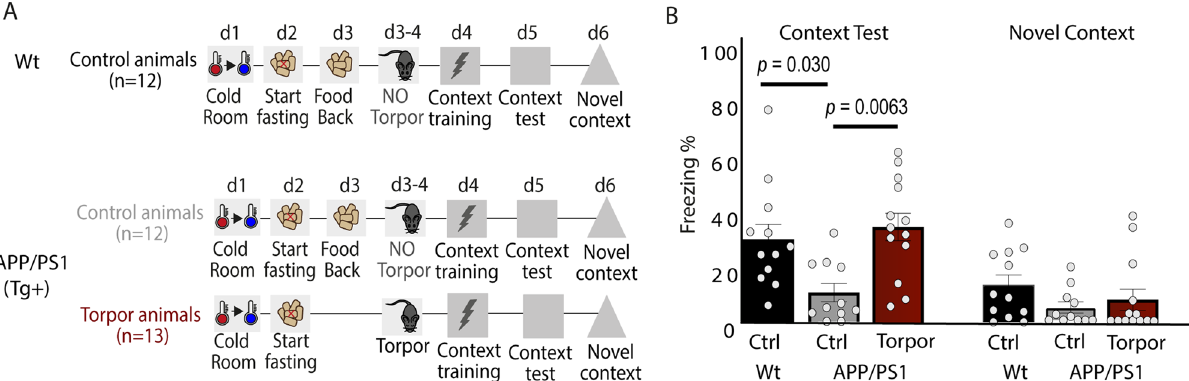
Figure 5. Torpor rescues memory deficits in APP/PS1 mice. ( A ) Torpor was induced in APP/PS1 mice. As controls, wildtype (Wt) and APP/PS1 mice were used that were refed to prevent torpor entry. All mice underwent fear conditioning on day 4 (d4) and context exposore on d5. On d6, they were tested in a novel context (NC). ( B ) Freezing levels were significantly diferent between groups (One-way ANOVA F 2,34 = 4.646, p = 0.0164). Freezing levels were significantly lower in APP/PS1 control mice compared with wildtype control mice (14.3% ± 4.7% vs 30.7% ± 5.5%; post-hoc Fisher’s LSD; p = 0.030), confirming a memory impairment in APP/PS1 mice. Torpor rescued freezing in APP/PS1 mice up to wildtype levels (35.0% ± 4.7% vs 30.7% ± 5.5%; post-hoc Fisher’s LSD; p = 0.0063). Little freezing was observed in the NC (wildtype control: 21.3% ± 4.6%,